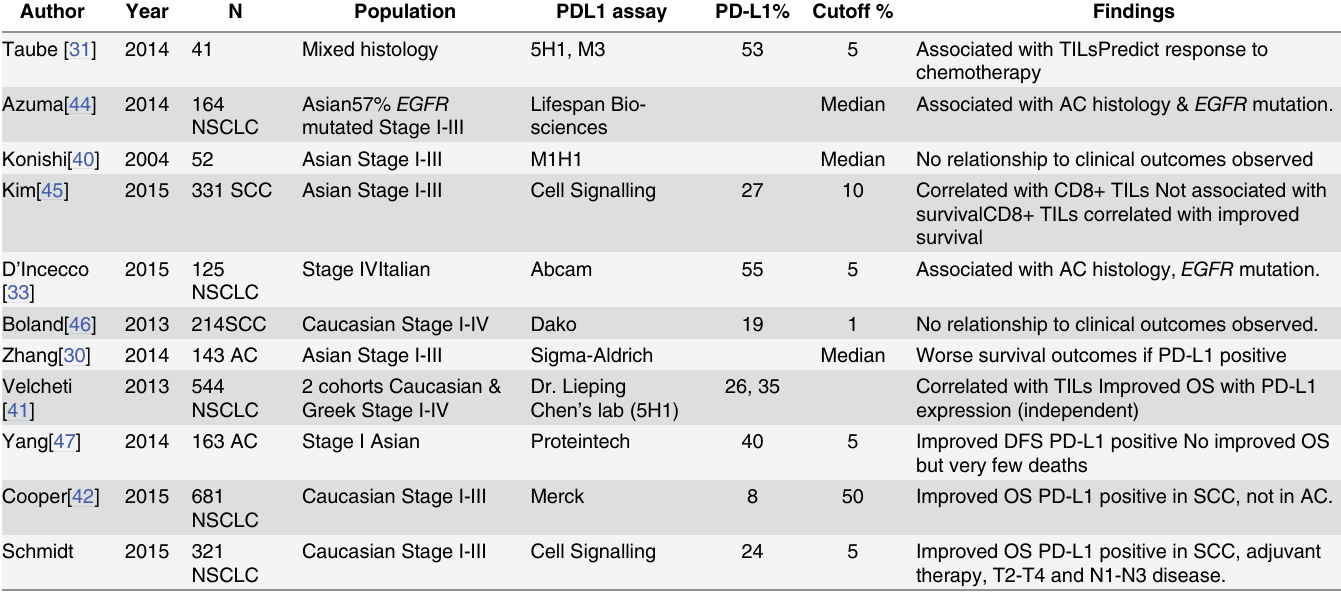
Table 3. Reported studies of PD-L1 in